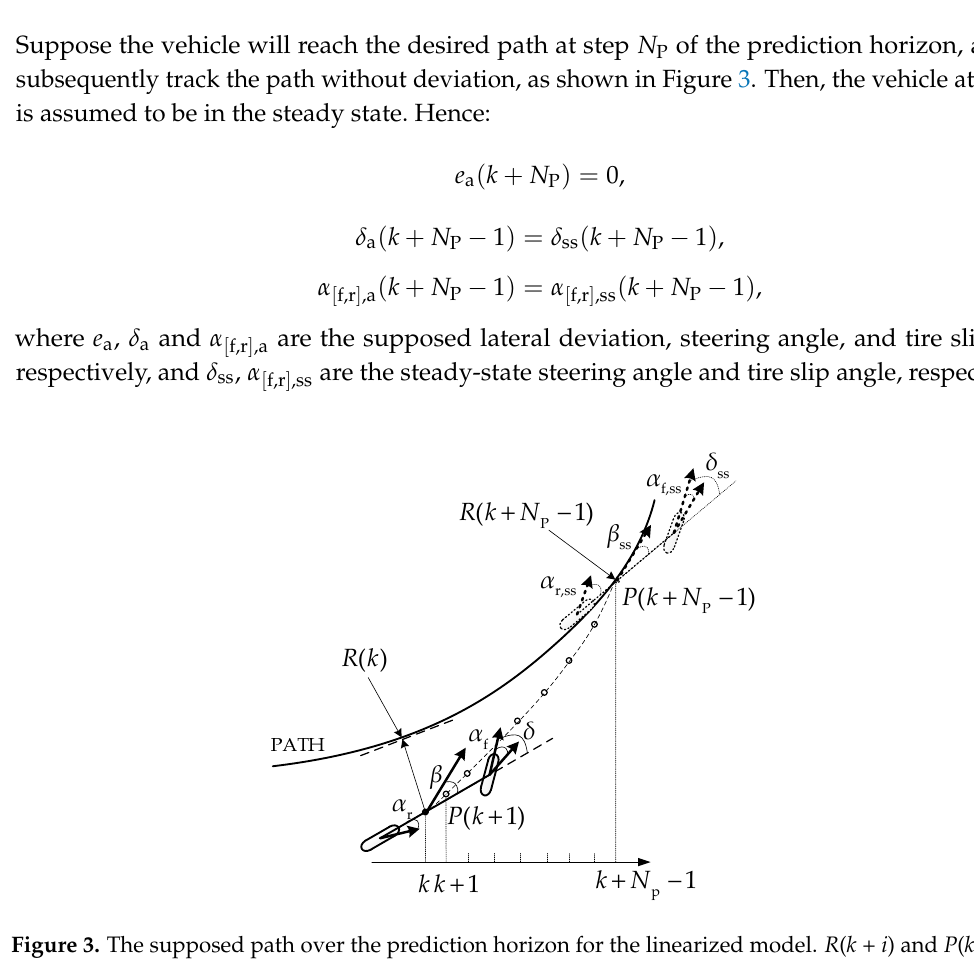
Figure 3. The supposed path over the prediction horizon for the linearized model. R ( k + i ) and P ( k + i ) denote the radius of the desired path and the supposed point at s ( k + i ), respectively, i = 0, . . . , N P − 1. . r = 0 in Equation (19), the front and rear tire Under steady-state cornering conditions, setting forces are